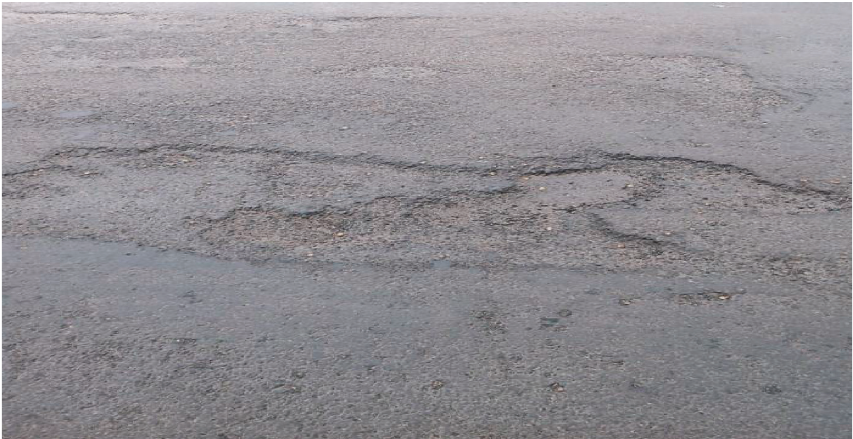
Figure 8: Ravelling at chainage 0.300km on the section UR13.